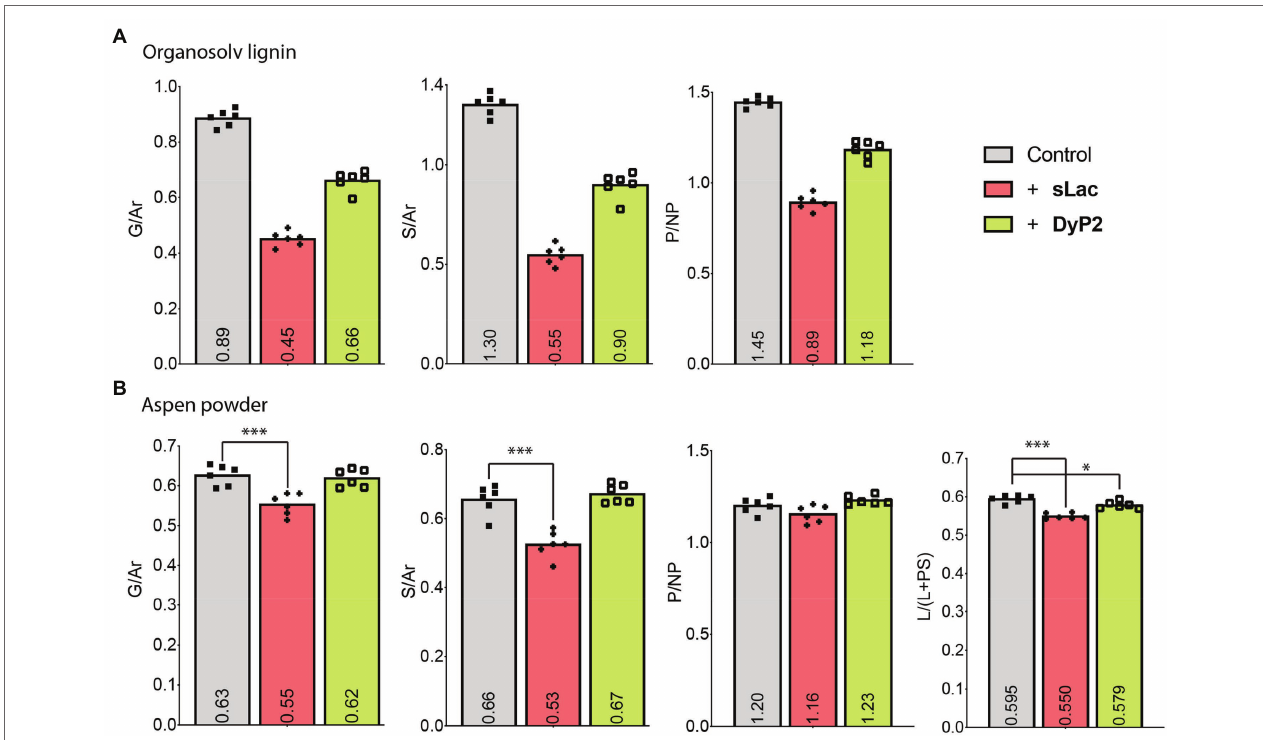
FIGURE 2 | The effect of sLac and DyP2 alone on organosolv lignin (A) and lignin in aspen wood powder (B) . G, S, Ar, L, PS, P, and NP are the combined intensity of peaks corresponding to intact methoxylated G-lignin, intact methoxylated S-lignin, nonfunctionalized aromatic rings, lignins, polysaccharides, phenolic structures, and non-phenolic structures, correspondingly. Six ToF-SIMS spectra ( n = 6) of each sample were acquired, shown as scattering dots, and their averages were reported as bar charts as well as numbers inside columns. ANOVA analysis with Tukey’s post-test for (B) : * and *** mean p = 0.02 and p < 0.0001, respectively.